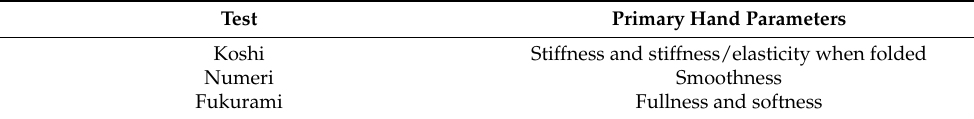
Table 3. Primary hand parameters for fabrics following the Kawabata Evaluation System.